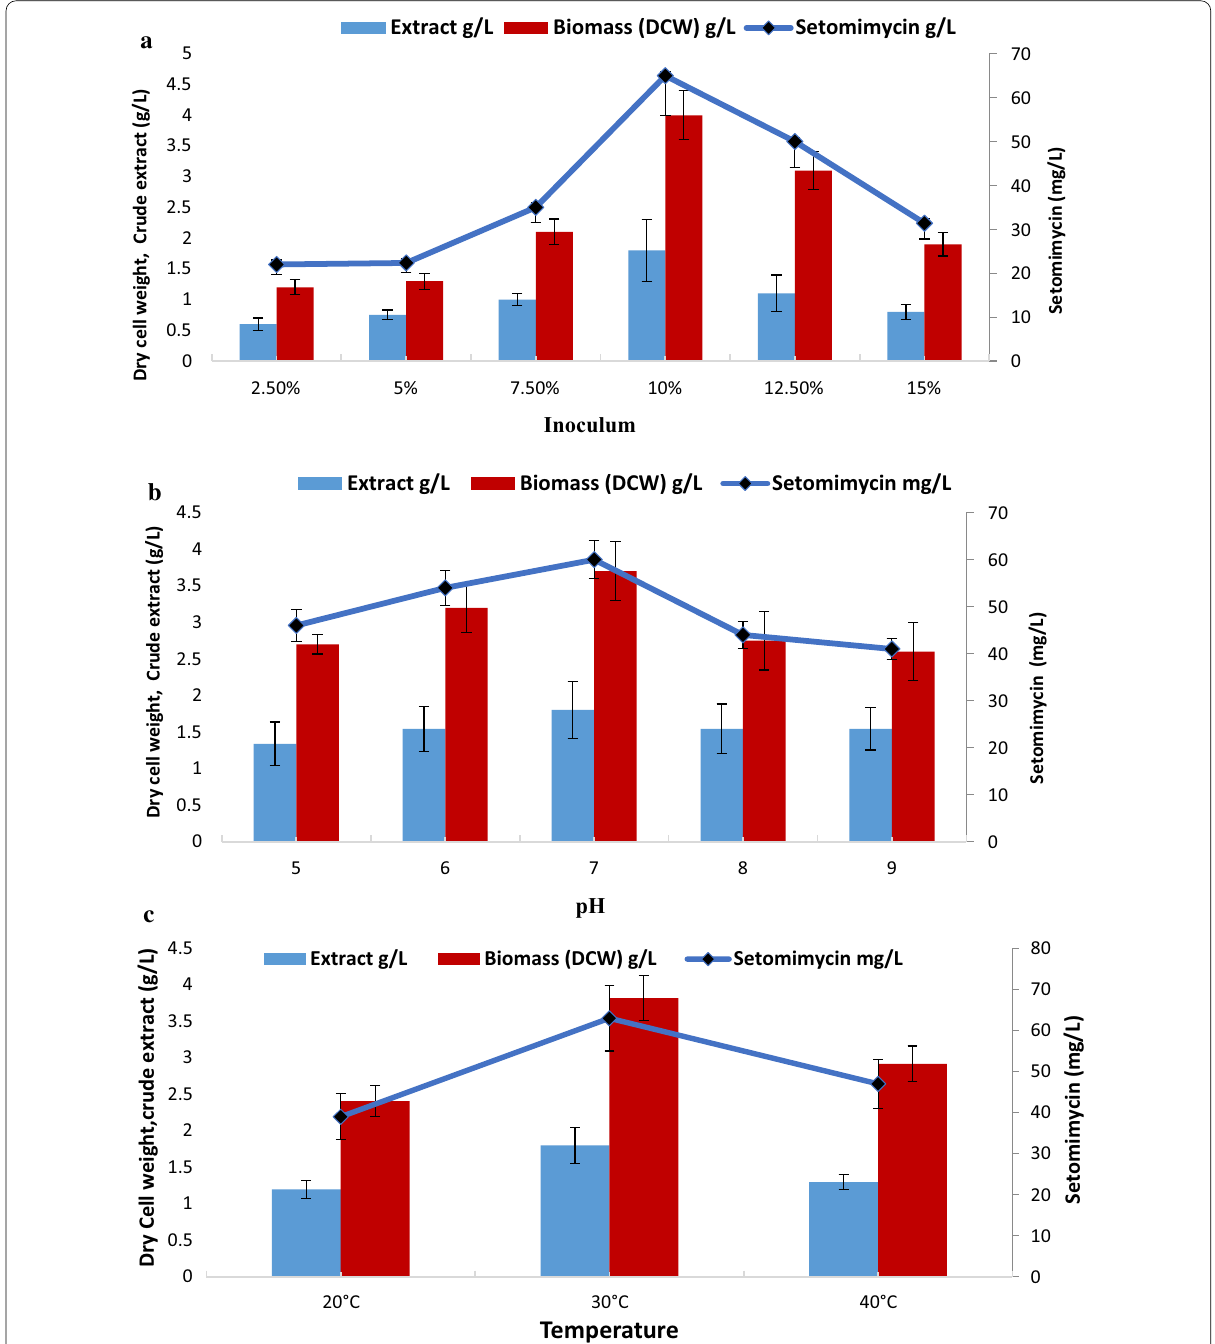
Fig. 2 Effect of fermentation conditions on setomimycin production by Streptomyces sp. RA-WS2 ( a ) Inoculum percentage ( b ) pH ( c ) Temperature ( d ) Agitation ( e ) Air to volume